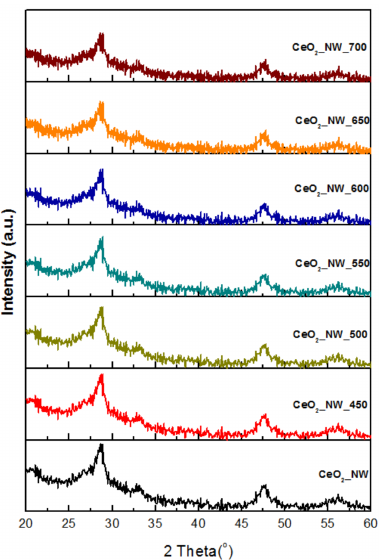
Figure 2. XRD patterns of CeO 2 nanowires reduced by H 2 as a function of temperature (450–700 ◦ C).